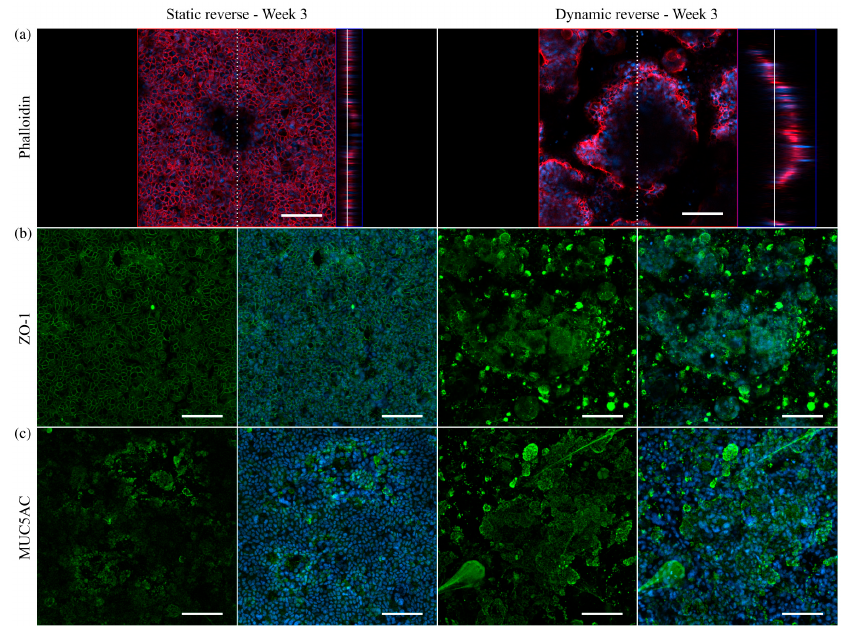
Figure 9. Confocal immunofluorescence images of HT29-MTX cells on Transwell ® -insert membranes under static and dynamic conditions after three weeks. ( a ) Confocal image and corresponding orthogonal view of F-actin stained with phalloidin (red). Dotted and straight white line indicate the cutting plane and the position within the z-stack, respectively. Nuclei were counterstained with Hoechst 33342 (blue). Orthogonal projections of samples stained with antibodies for ( b ) ZO-1 as an integral part of tight junctions (green) and ( c ) the secreted mucin MUC5AC (green). (Scale bars: 100 µm).